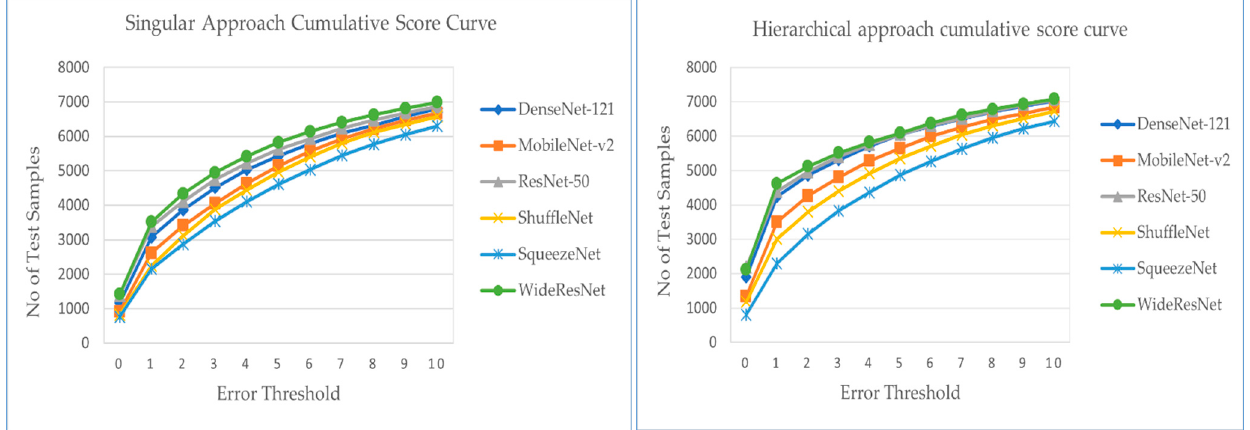
Figure 9. Plotted cumulative score of all CNNs deployed for real age estimation task using singular and hierarchical approach.